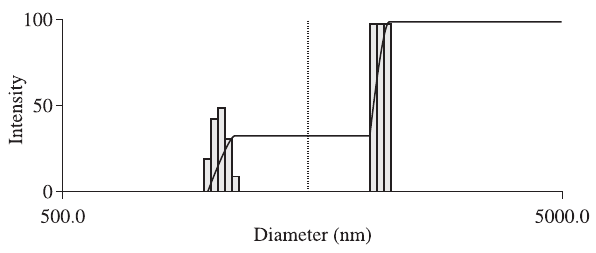
Figure 5. Results of Dynamic light Scattering of Sample B2 PEG. (NNLS)